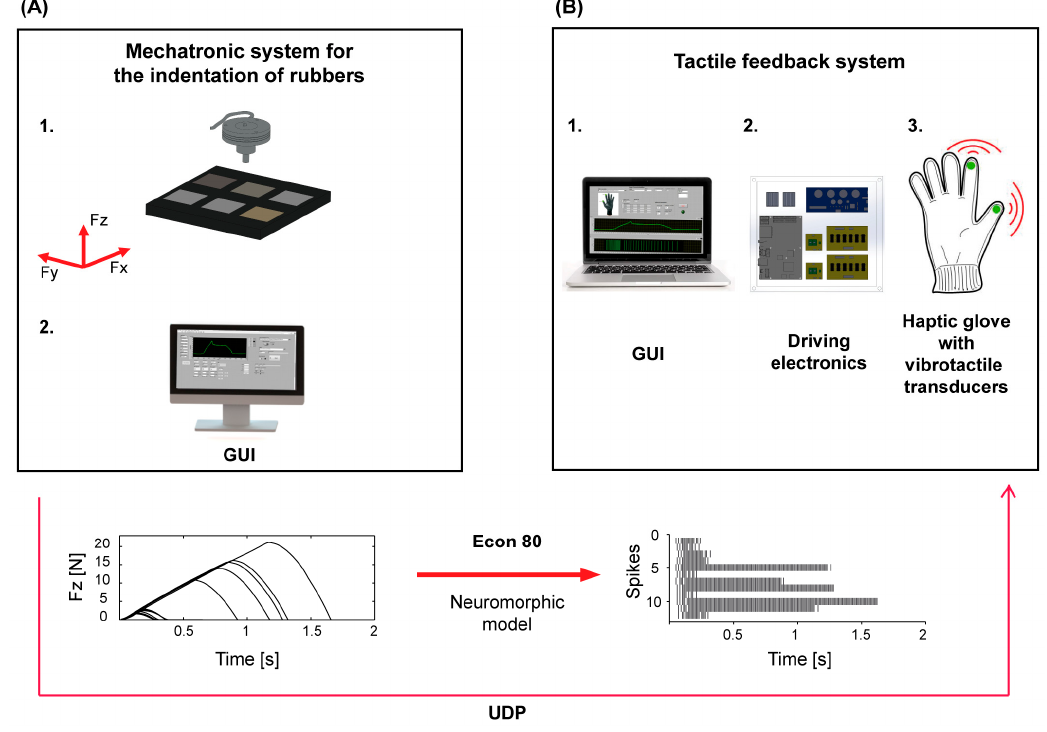
Figure 1. Experimental setup. ( A ) Subsystem I: 1. Sliders system with load cell and probe for the indentation of the rubber samples at controlled velocity; 2. Interface for the control of the platform operation and for sending data from the load cell to the second environment (remote laboratory); ( B ) Subsystem II: 1. Graphical User Interface (GUI) for the activation of the glove; 2. Driving electronics; 3. Haptic glove for the bi-digital stimulation of the hand. The two sub-setups were spatially separated, since the former was located in Italy and the latter in Ireland. The plots at the bottom of the figure depict how the normal force readings are converted into spikes by means of the implemented Izhikevich artificial neuron model.